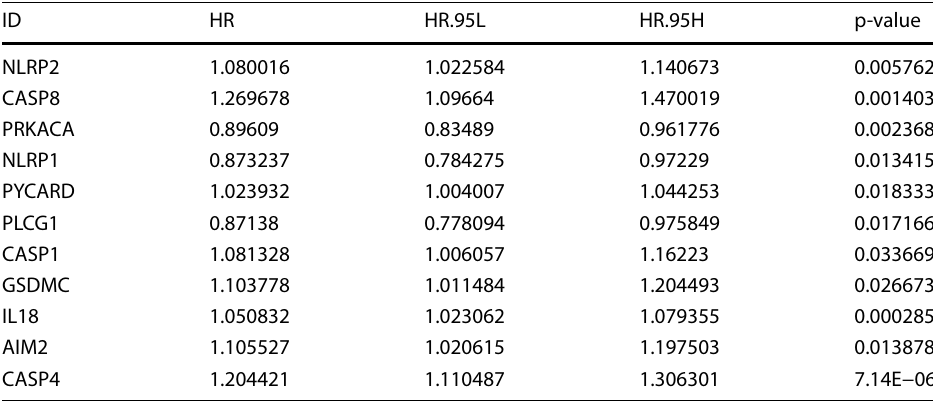
Table 3 Tree diagram of univariate Cox regression between PRGs and prognosis of PDAC